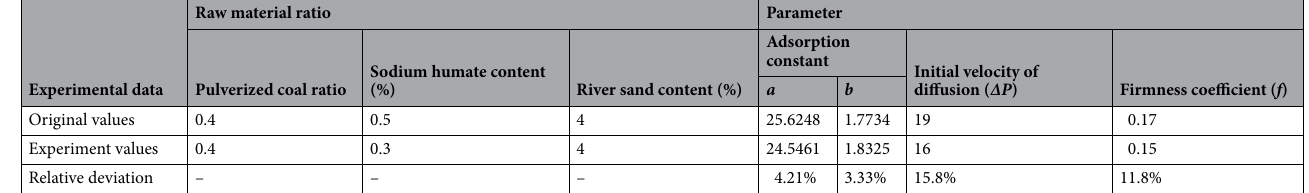
Table 10. Comparison of adsorption constant, firmness coefficient and initial diffusion velocity of similar materials between experiment values and original